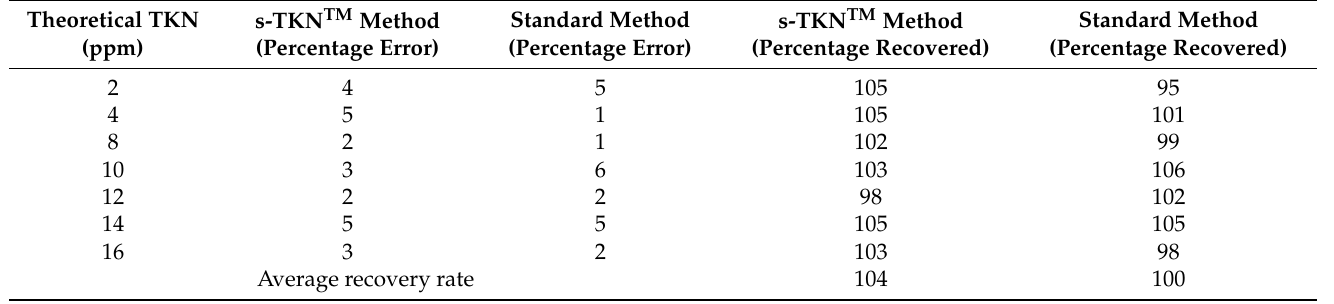
Figure 2. TKN concentrations in urea analyzed using the s-TKN TM method and standard method. Table 3. Error rates and recovery rates of nitrogen using the simplified TKN method and the Standard method (EPA (351.2) using the urea standard.